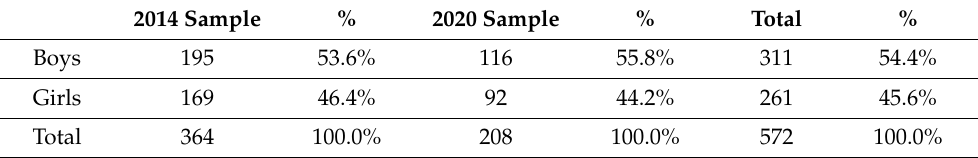
Table 1. Distribution of the sample by gender and year of data